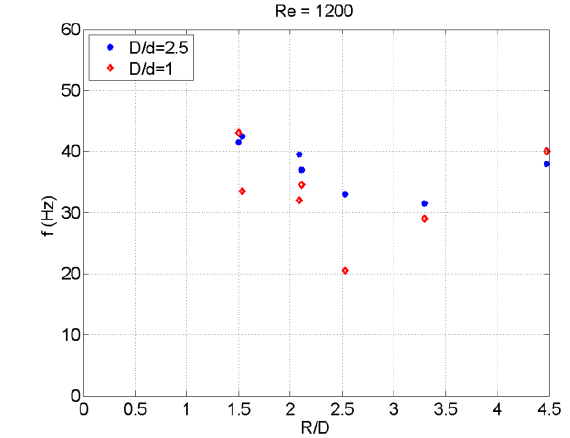
Figure 9. Relationship between the frequency and the pitch distance for Re 1930